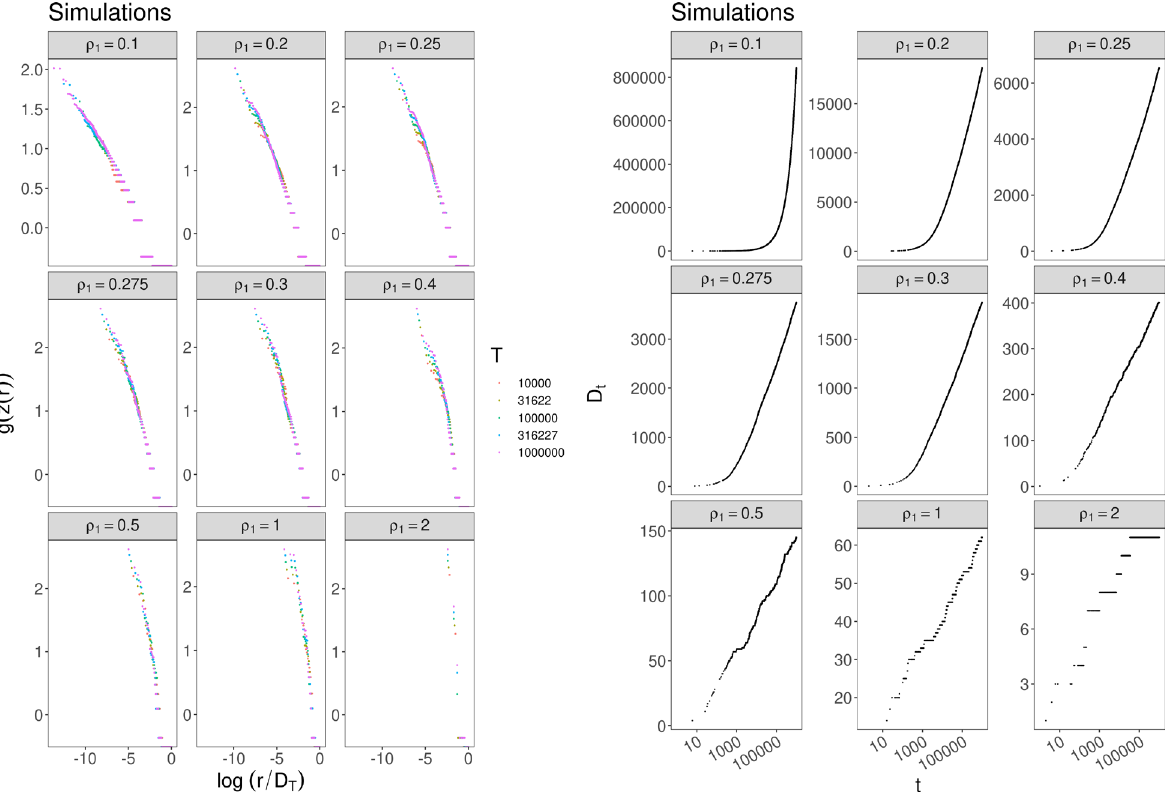
2 , ν 0.75 and different values of ρ 1 : (Left) Frequency-rank Figure 3. Simulations for case (7) with N 0 = = ln ( ln ( z )) . The different colors of the dots correspond to different quantities of data taken for plot with g ( z ) = depicting the plot. (Right) Behavior of D t .